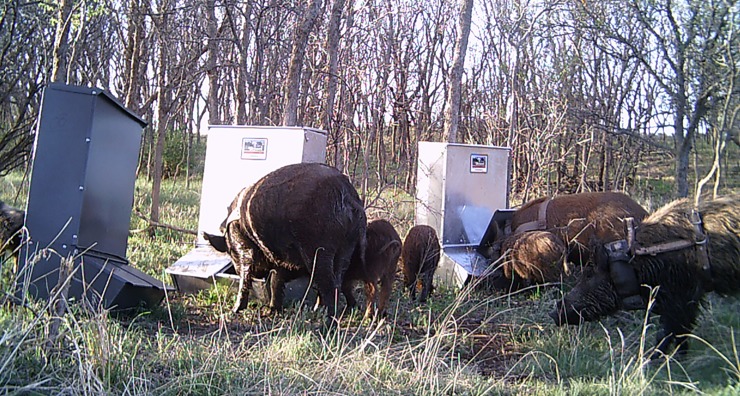
Wild pigs investigating and lifting doors to commercial feeders.GPS collars can be seen on the three large pigs.